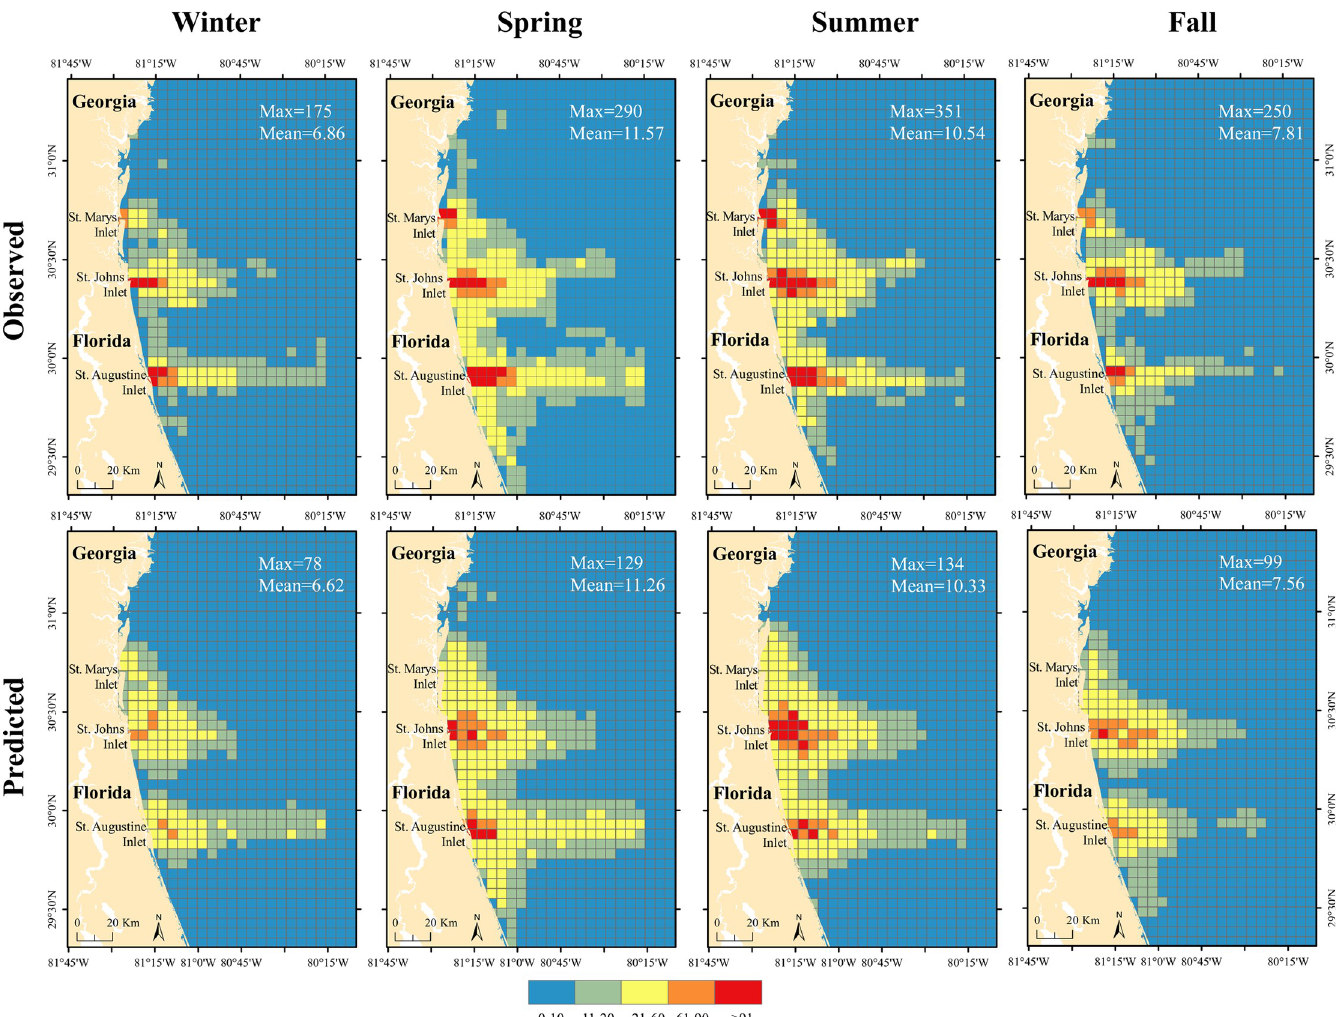
Fig 4. Observed and predicted offshore recreational boating trip abundance per grid cell for different seasons using